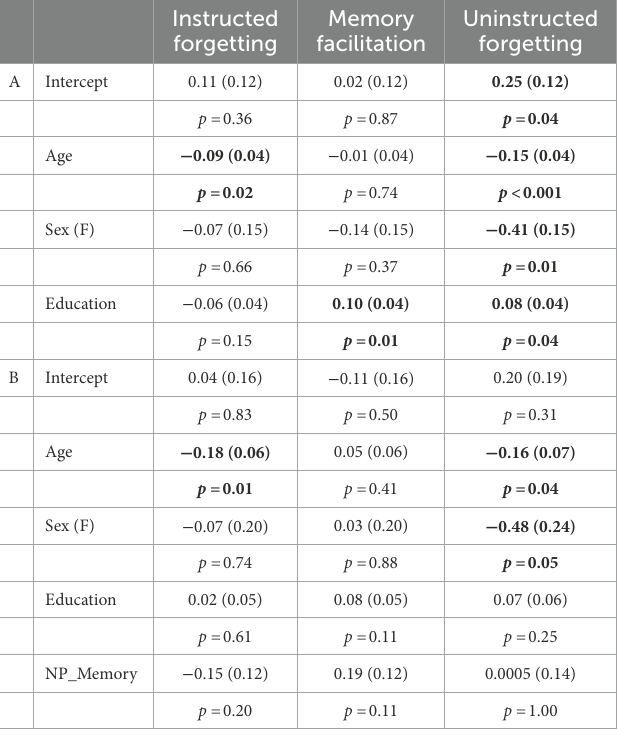
The table shows the regression estimates from 6 different models that evaluate the relationship of the three PC scores with A. Age, Sex (Female) and Education, in the full cohort; and B. In a subset of 100 participants with available neuropsychological episodic memory (NP_Memory) adjusted for age, sex and education. Age and Education were centered at 50 (in decades) and at 15 (in years), respectively. Note the p values are not corrected for multiple comparisons. If applying a Bonferroni correction for three tests, the association between sex and Uninstructed Forgetting would not be significant due to the large range of this particular